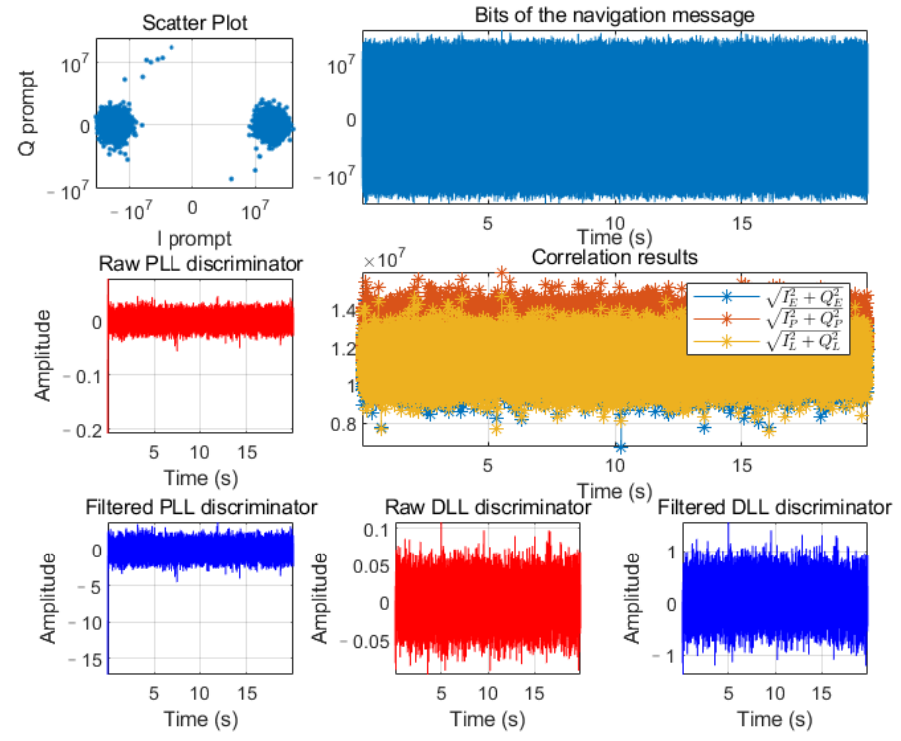
Figure 20. Tracking results of the proposed strategy (C/N 0 = 50 dBHz, D = 0.2). Figures 21 – 24 presents the SQM metric in the same four cases.